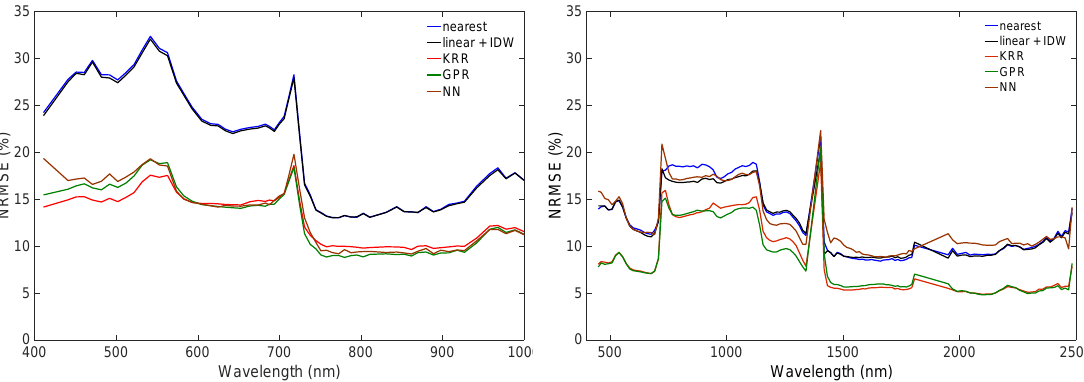
Figure 1. Wavelength-dependent NRMSE (%) results of the two interpolation methods and the three tested emulators, i.e., KRR, GPR, NN for CHRIS ( left ) and HyMap ( right ) datasets.